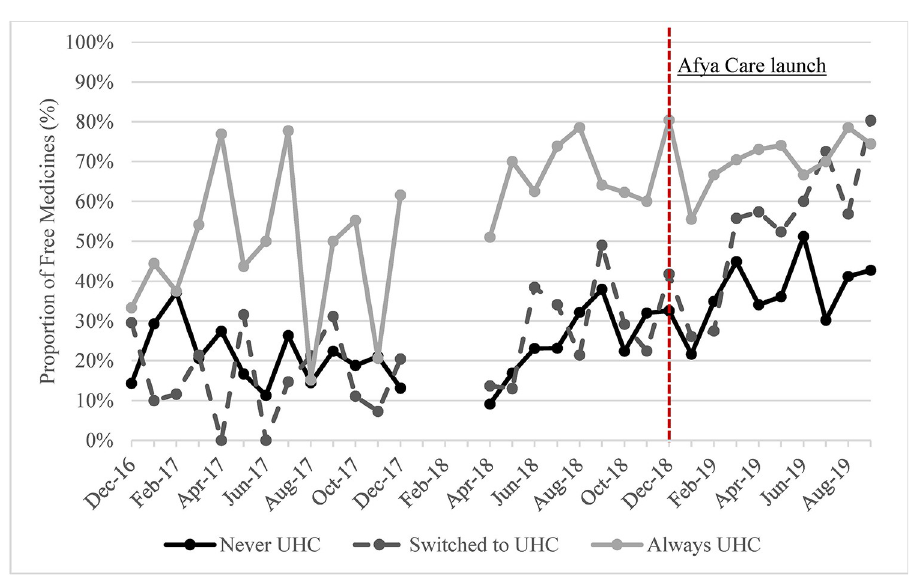
Fig 5. Proportion of NCD medicines obtained free of